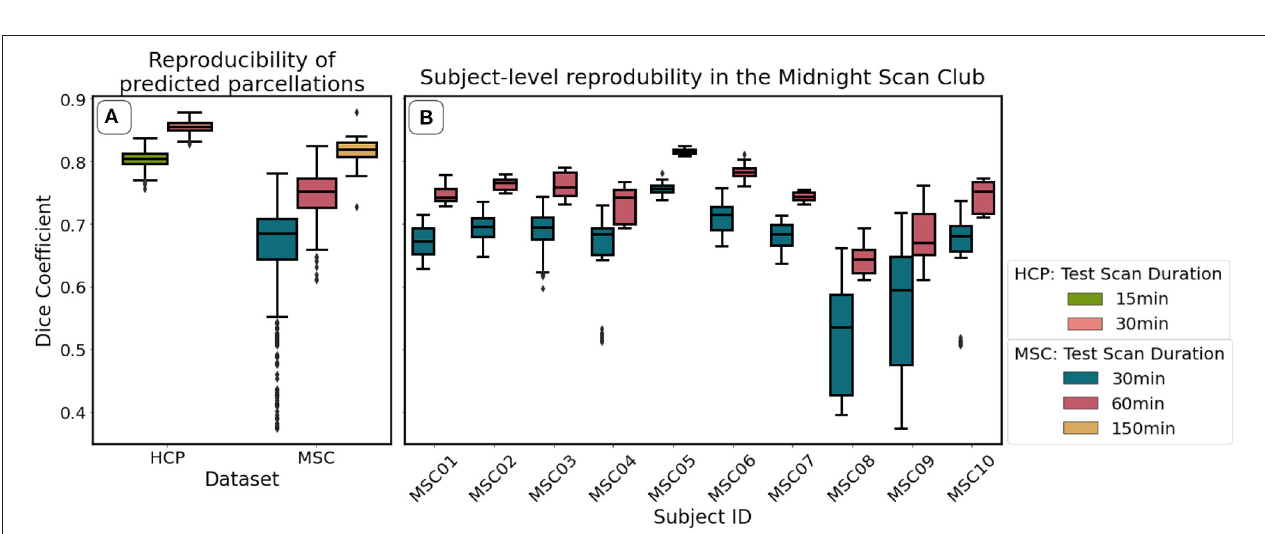
FIGURE 7 | Reproducibility of predicted maps generated by the optimal model, as measured using the Dice coefficient. We show mean reproducibility estimates for each dataset (A) , and subject-level estimates in the Midnight Scan Club (B) . Estimates for 60 min (HCP) and 300 min (MSC) durations are not shown in (A) because there is only one image per subject for these durations. Similarly, estimates for 150 min durations are not shown in (B) because there is only a single scalar estimate per